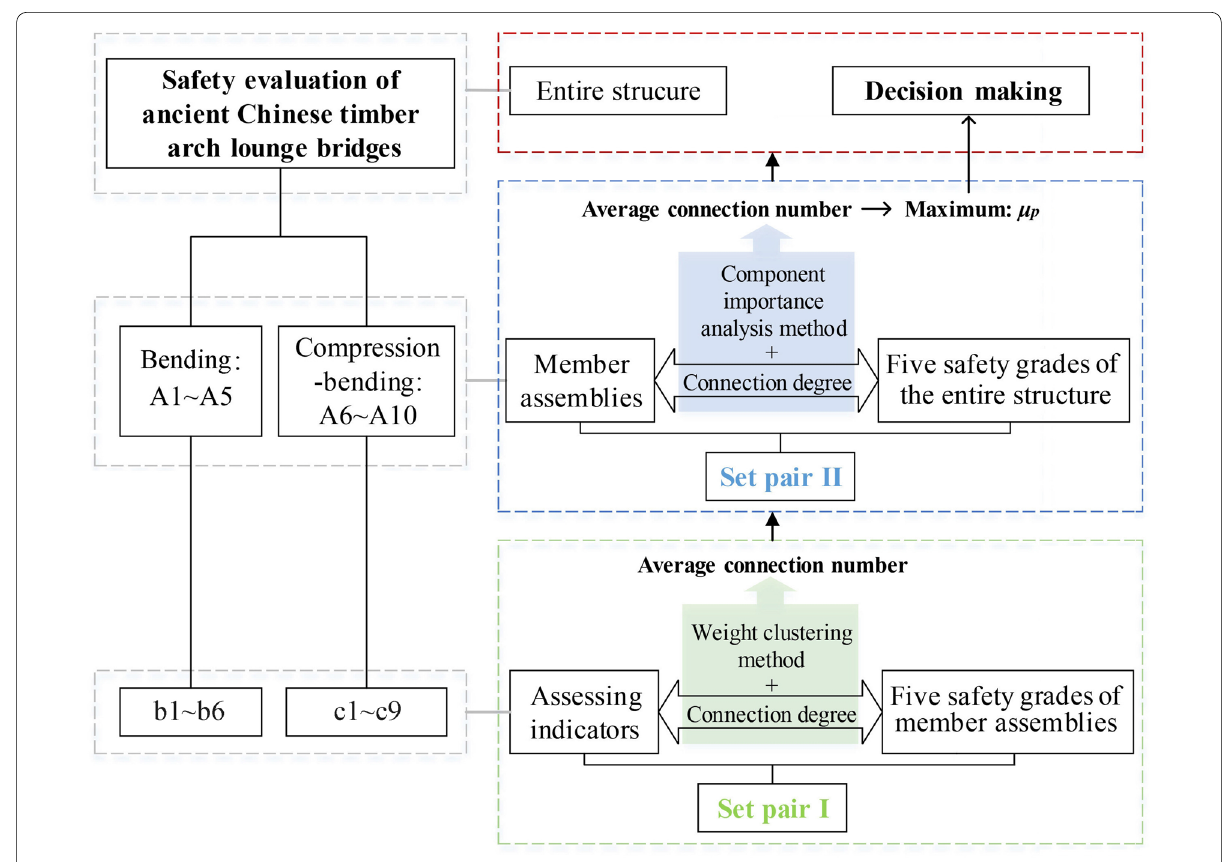
Fig. 5 Roadmap of performing the safety evaluation procedure